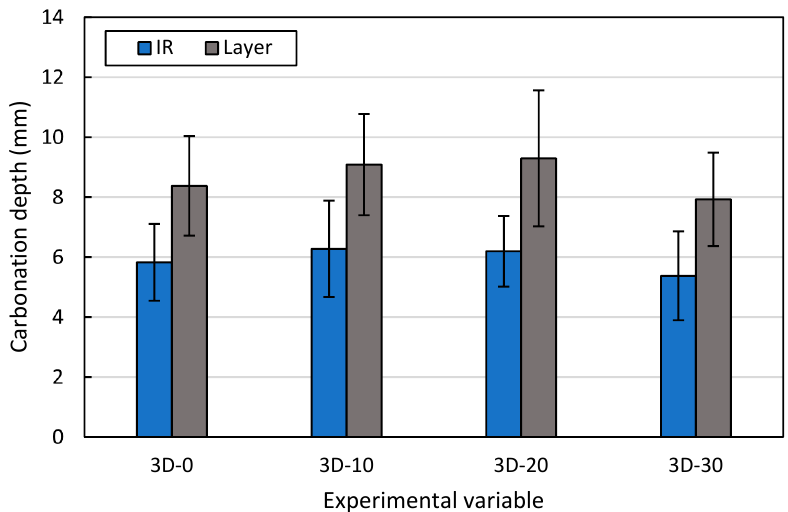
Figure 19. 12-week carbonation depth at the IRs compared to layers.